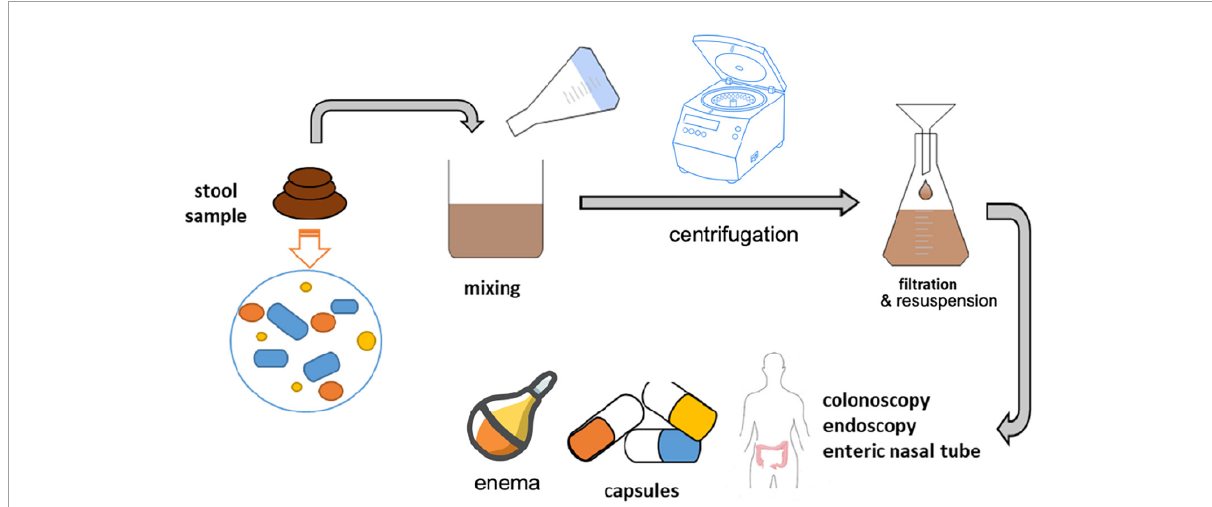
FIGURE3 Fecal sample preparation: After testing for contaminants and pathogenic species, stool samples are mixed with saline and glycerol with a final ratio of 25% stool, 65% saline, and 10% glycerol. Mixing is done through a blender or centrifugation to homogenize the sample with the adequate ratio of substrates. The mixture is then filtered and resuspended until it is fully homogenized. The homogenized solution is stored in cryotolerant containers at –80 ◦ C for FMT use. When ready for use, the solution is loaded into capsules or delivered through colonoscopy, endoscopy, enteric nasal tube or